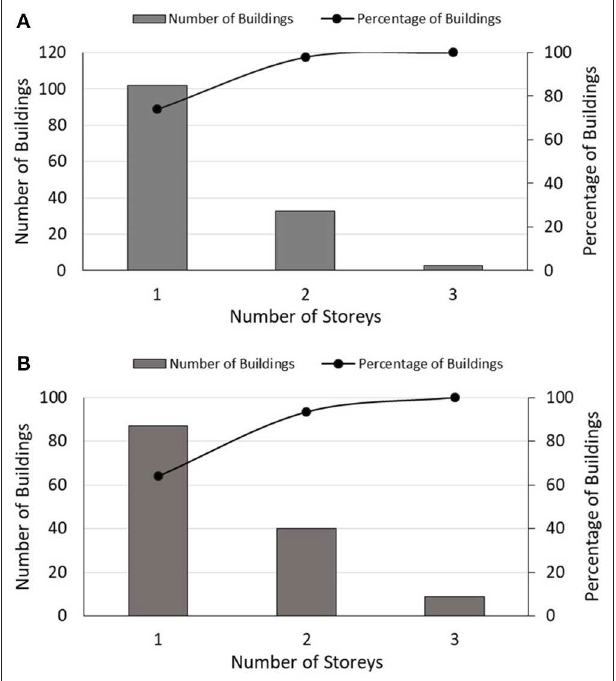
FIGURE 2 | Frequency and cumulative percentage of the buildings as a function of the number of stories for (A) URM buildings and (B) CM buildings (original).